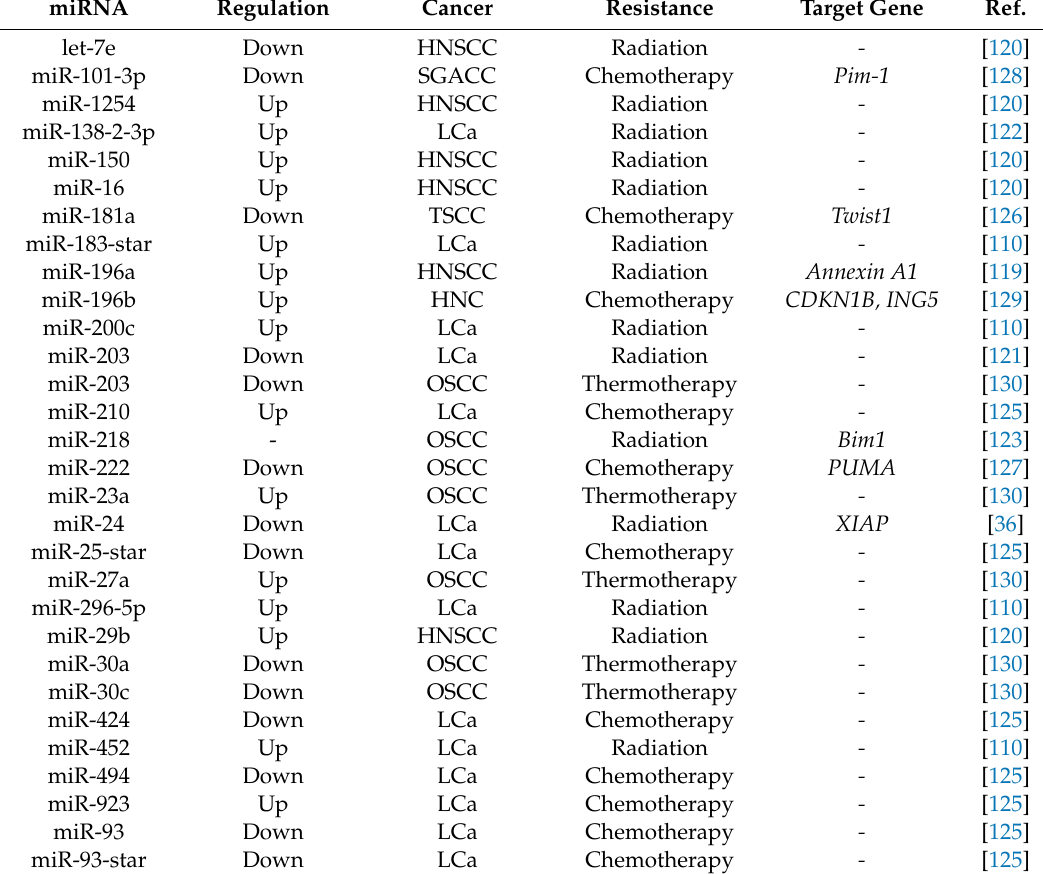
Table 4. Relationship between miRNA deregulation and resistance in